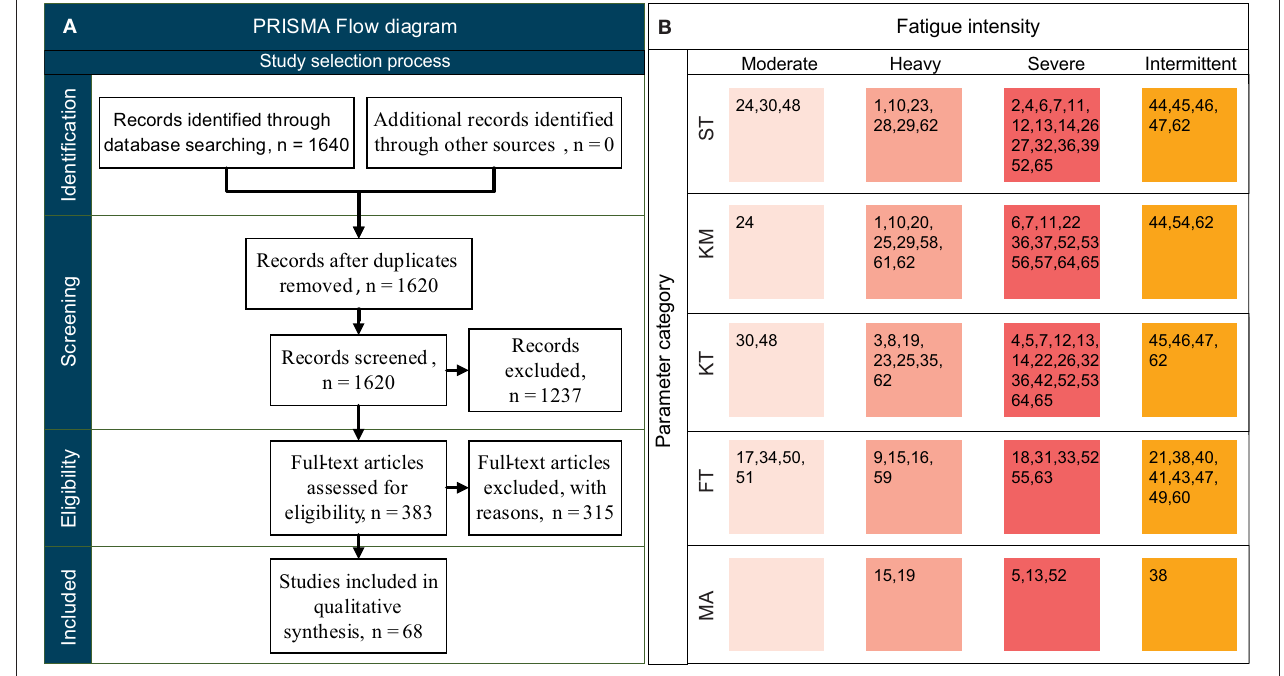
FIGURE 1 | (A) PRISMA flow chart for study selection, adapted from Page et al. (2021). (B) References for the included 68 studies (1. Siler and Martin, 1991, 2. Verkerke et al., 1998, 3. Voloshin et al., 1998, 4. Willson and Kernozek, 1999, 5. Mizrahi et al., 2000a, 6. Mizrahi et al., 2000b, 7. Derrick et al., 2002, 8. Dutto